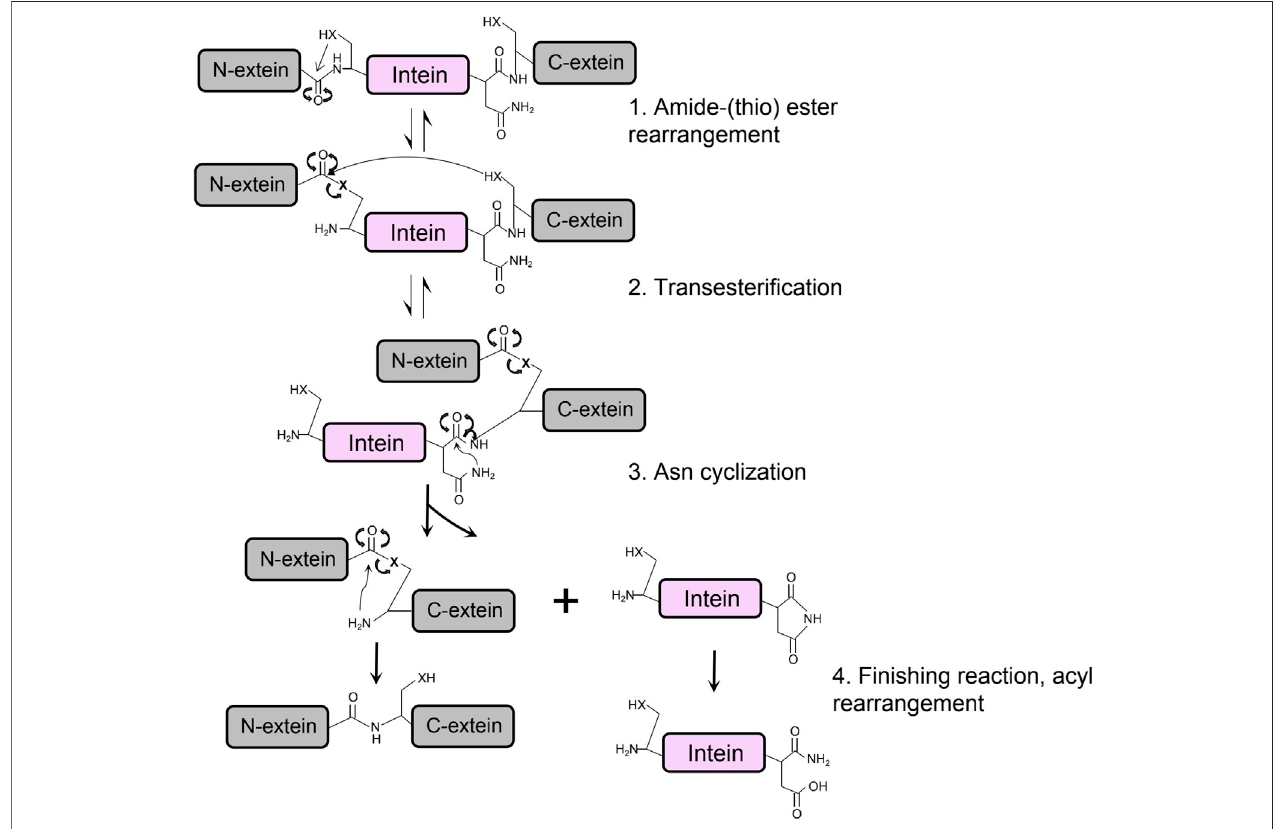
FIGURE 3 | The protein splicing mechanism of class 1 intein composes four main steps, in which X is referred to an oxygen or sulfur atom.